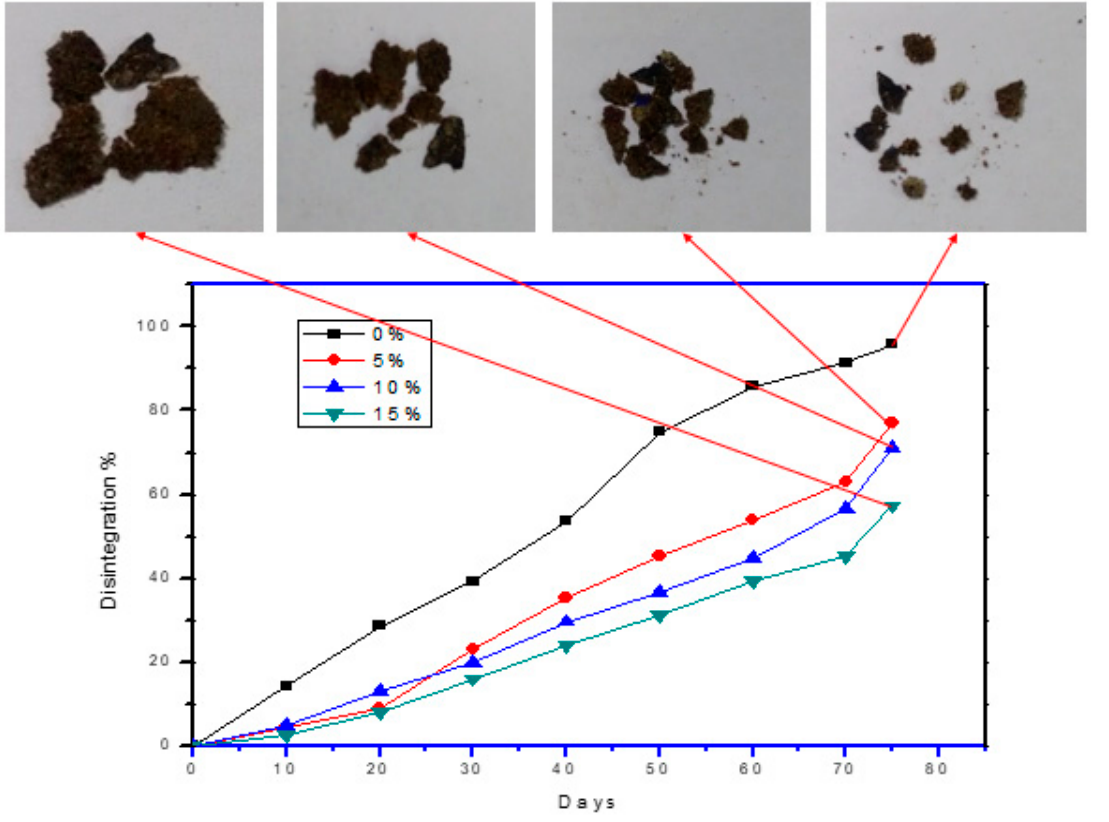
Figure 11. Bio-degradation test with 0, 5, 10, and 15 wt % of graphite with PCP.